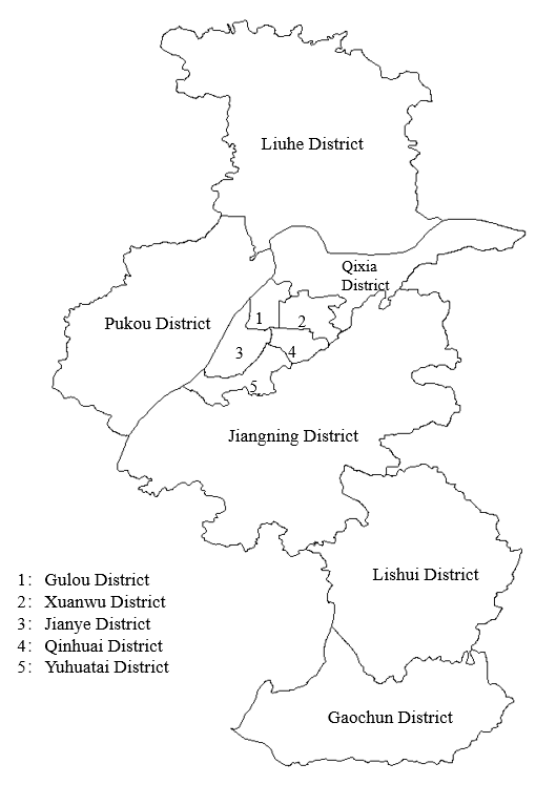
Figure 1. Nanjing administrative divisions.